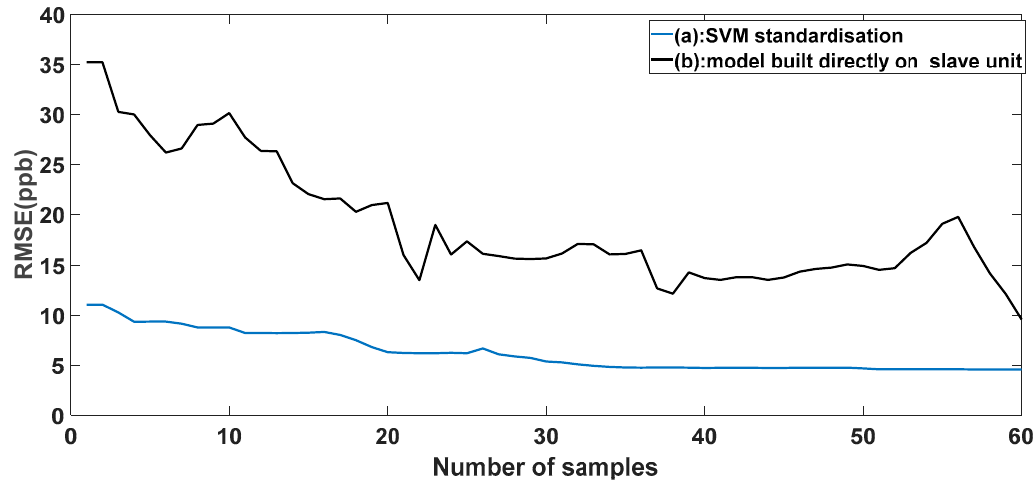
Figure 6. ( a ) Evolution of root mean square error as a function of the standardization sample number by using the master calibration model. ( b ) Evolution of root mean square error as a function of the sample number used for building a new model directly on the slave unit.